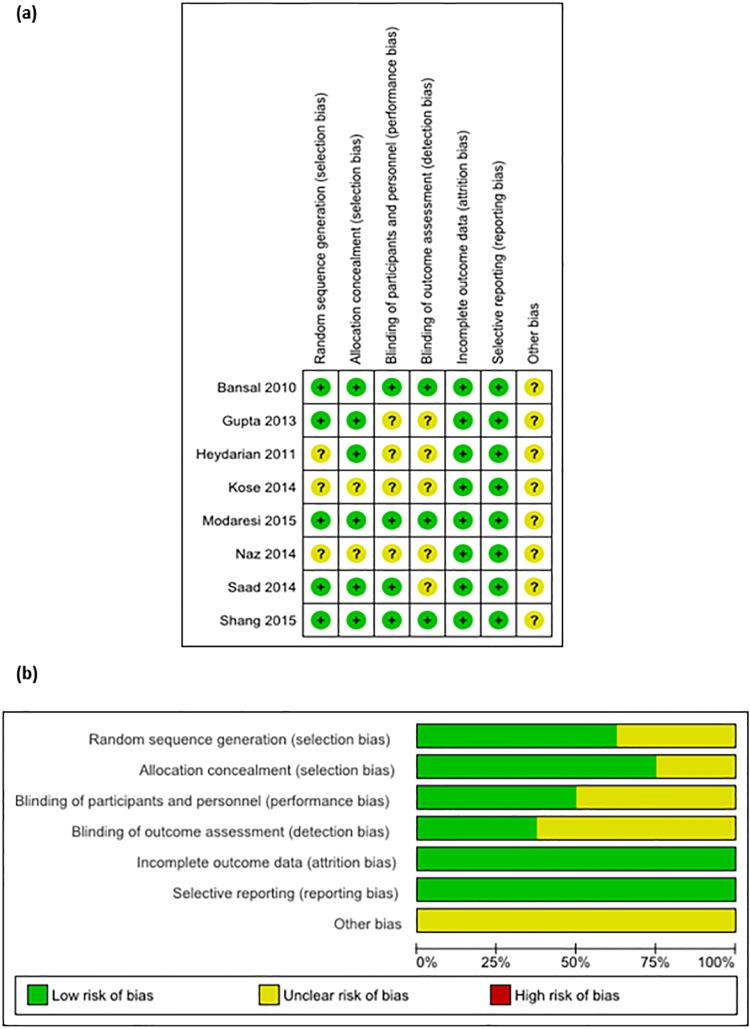
Assessment of risk of bias according to a recommended tool for randomized controlled trials by the Cochrane Handbook for Systematic Reviews of Interventions.(a) Risk of bias summary showing review authors’ judgments about each risk of bias domain for 8 randomized controlled trials. (b) Risk of bias graph showing each risk of bias domain presented as percentages across the studies.